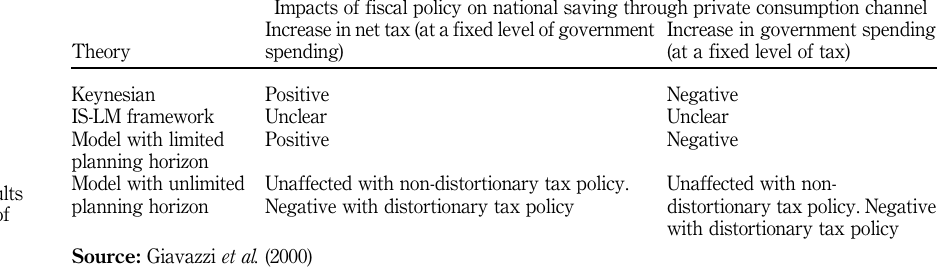
Table I. Theoretical results of the impacts of fiscal policy on national